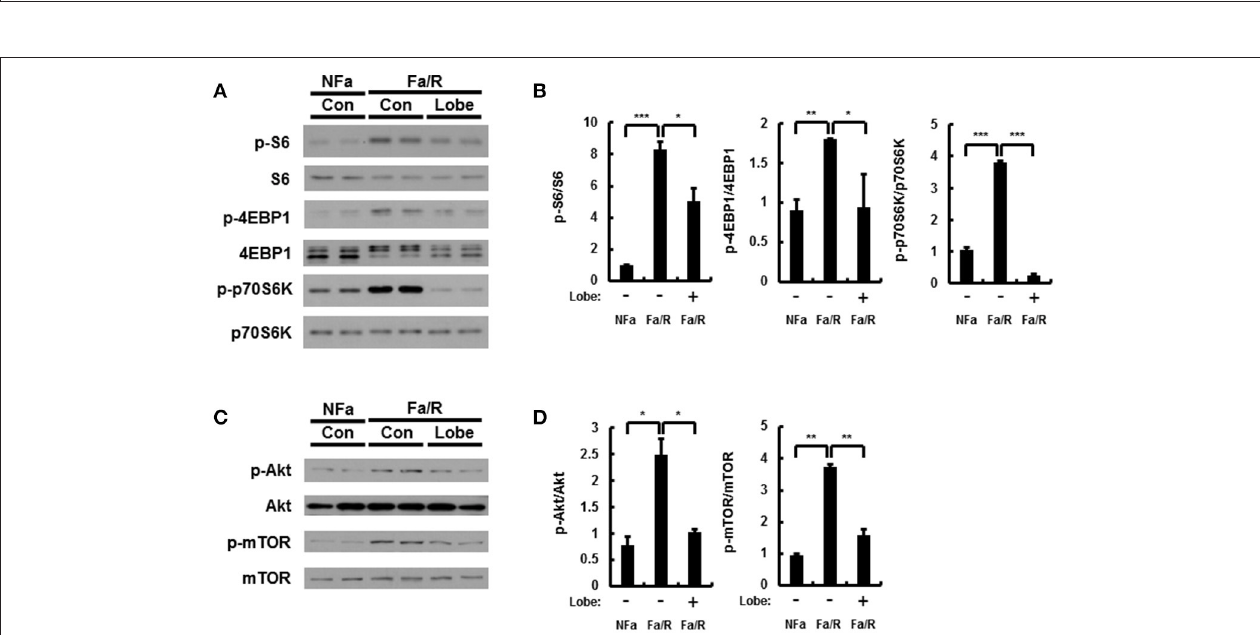
FIGURE 4 | Lobeglitazone inhibits mTORC1 signaling induced by acute lipogenic stimulus in liver. (A–D) Mice were maintained in a non-fasted state (NFa) ( n = 8) or fasted overnight and then refed a high-carbohydrate, fat-free diet (Fa/R) with vehicle ( n = 9) or lobeglitazone ( n = 9). (A,C) The livers from eight or nine mice of each group were pooled and homogenized; subsequently, the homogenates were subjected to immunoblotting analysis with antibodies to the indicated proteins. (B,D) The intensity of protein bands in (A,C, respectively) was determined by densitometry. The data in (B,D) are presented relative to the corresponding value for non-fasted mice and are the mean ± standard error for eight or nine mice in each group. * p < 0.05, ** p < 0.01, and *** p < 0.001.